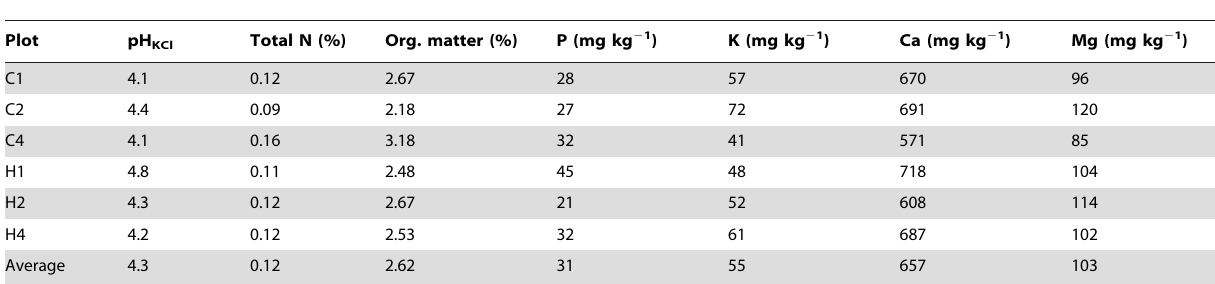
Table 2. Chemical properties of the soil humus horizon in the experimental plots.